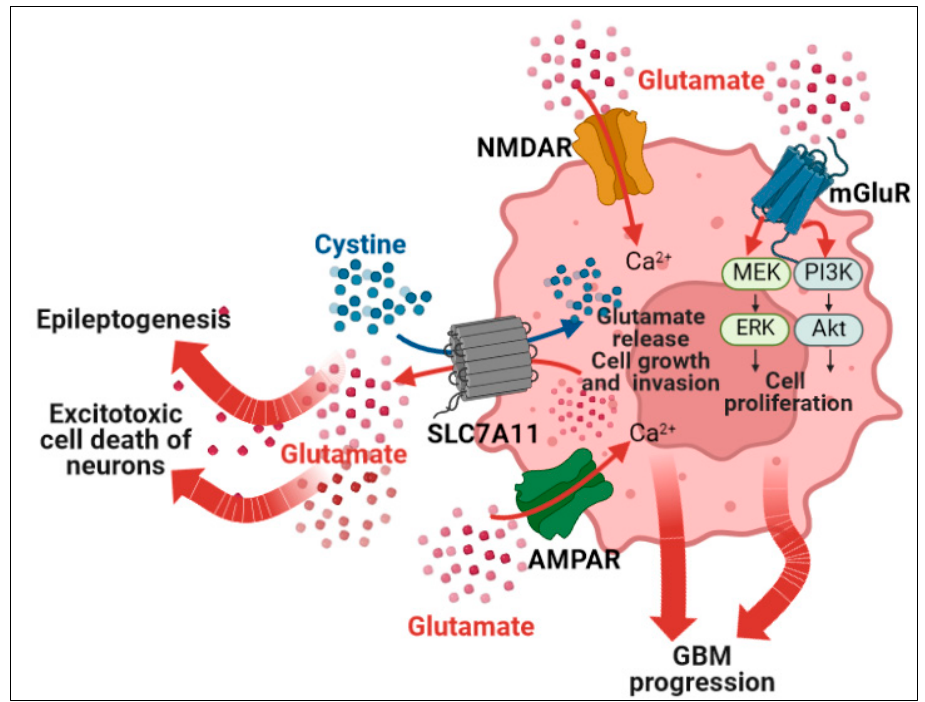
Figure 2. Main glutamatergic signaling in glioblastoma cells and peritumoral neurons leads to tumor progression and epileptic onset. SLC7A11 (cystine/glutamate antiporter solute carrier family 7 member 11) is often upregulated in glioblastoma (GBM) and associated with seizures. GBM cells release glutamate via SLC7A11 in exchange for cysteine (precursor glutathione which mitigates oxidative stress and sustains GBM cell survival) uptake. The abundant release of glutamate concurs to enhance the excitotoxicity of GBM surrounding neurons and contributes to tumor growth in a paracrine manner. The upregulated glutamatergic activity in neurons stimulates glioma growth and signaling via ionotropic glutamate AMPA and NMDA receptors (AMPAR and NMDAR), which are also involved in seizure onset. GluR2 subunit-lacking AMPARs are highly Ca 2+ permeable leading to increased Ca 2+ influx in GBM cells that (a) enhances glutamate release to surrounding cells, (b) triggers growth- and invasion-related pathways in GBM cells, (c) impacts neuro-gliomal glutamatergic synapses. NMDARs are highly expressed in synapses but also in glia and GBM cells. NMDARs concur to increase intracellular Ca 2+ levels via activation of mGluRs glutamatergic transmission in both neurons and glia, and glioma. Metabotropic glutamate receptors (mGluRs) are G-protein-coupled receptors that affect ion exchange when activated by glutamate and regulate major pro-survival and proliferative signaling pathways such as MEK/ERK (mitogen-activated protein kinase kinase 1, MEK; extracellular signal-regulated kinase ERK), and PI3K/Akt (phosphatidylinositol-3 kinase, PI3K; serine/threonine kinase,